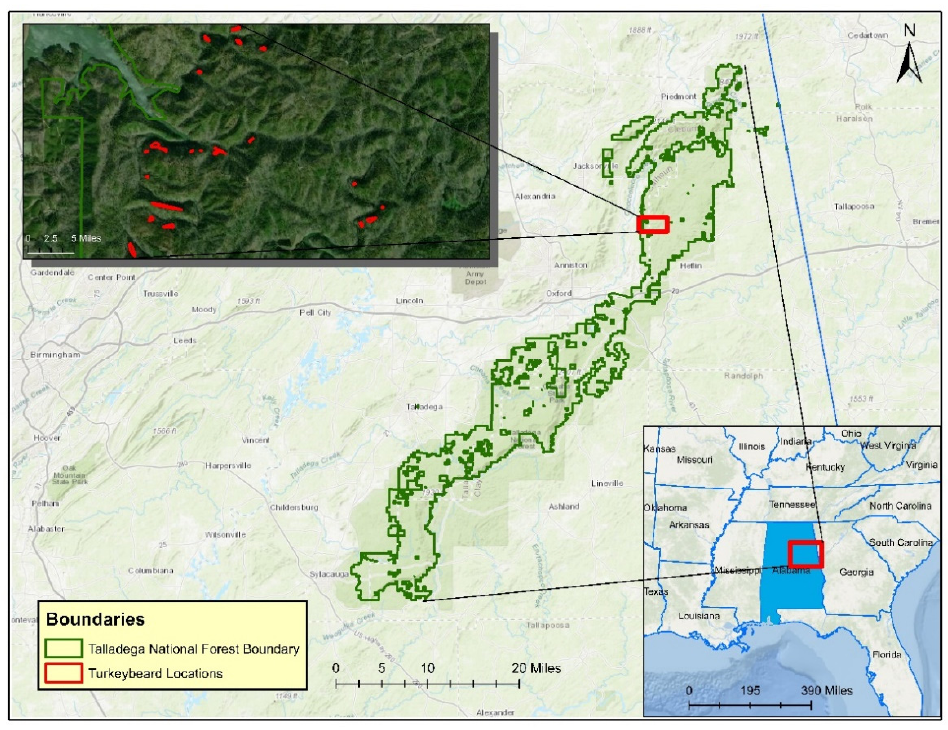
Figure 1. Talladega National Forest and turkeybeard occurrence locations (from field observations). (Basemap sources: ESRI).